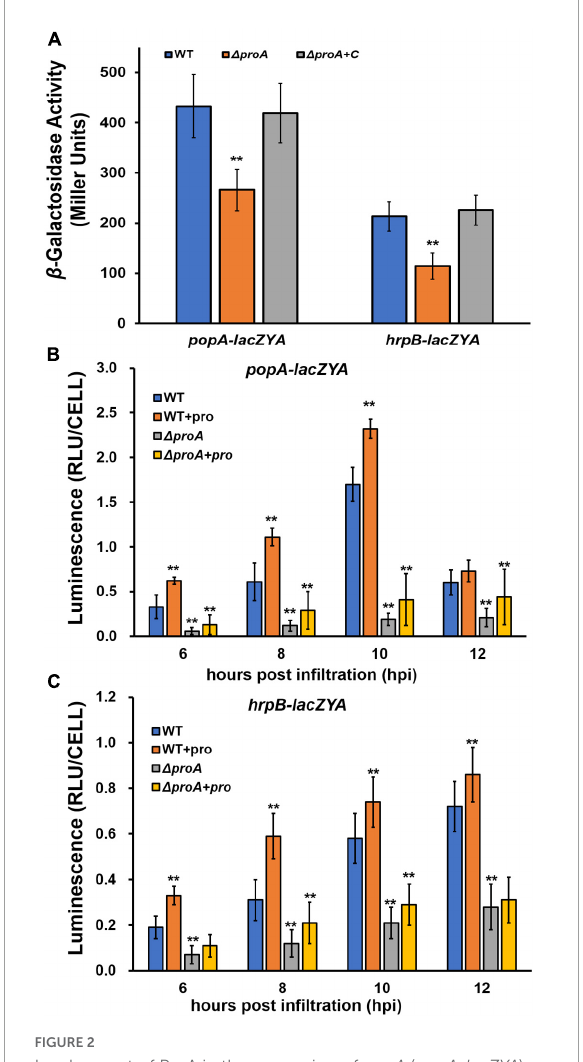
FIGURE2 Involvement of ProA in the expression of popA ( popA-lacZYA ) and hrpB ( hrpB-lacZYA ). The wild type (WT) refers to reporter strains of RK5050 (OE1-1, popA-lacZYA ) and RK5046 ( hrpB-lacZYA ); (cid:49) proA refers to deletion of proA from RK5050 (OE1-1, popA-lacZYA ) and RK5046 ( hrpB-lacZYA ). (cid:49) proA + C refers to complementary proA in (cid:49) proA mutant strains; + pro, supplemented proline into tobacco leaves. (A) Expression of popA-lacZYA and hrpB-lacZYA in hrp -inducing medium